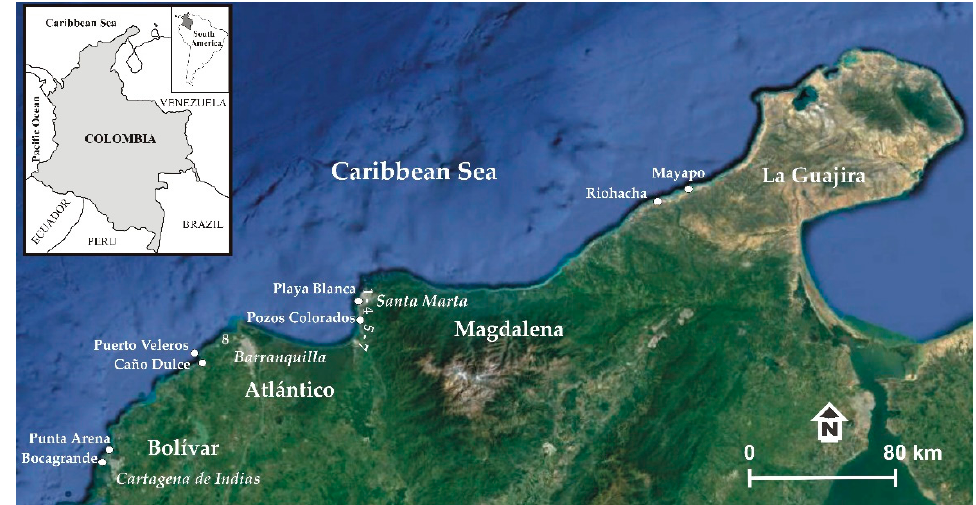
Figure 1. Location map of the beaches where litter surveys were carried out. Numbers refer to beaches where enquiries were carried out (see text).